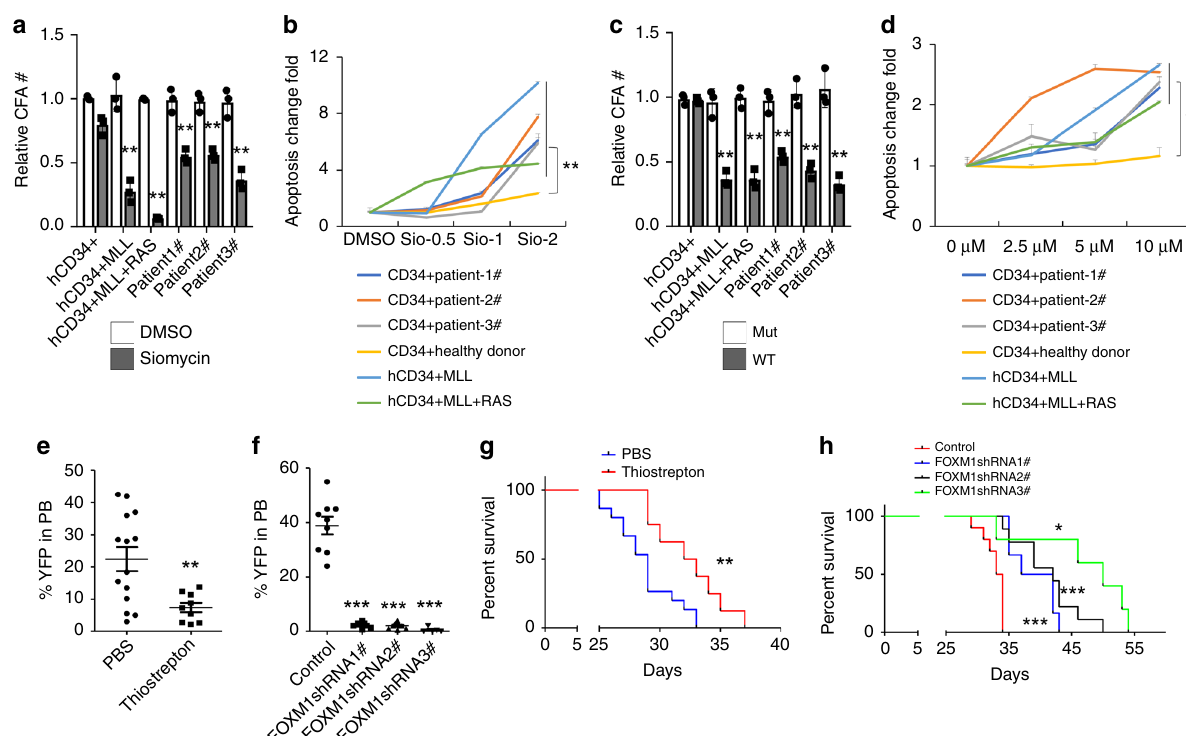
Fig. 8 Inhibition of FOXM1 suppressed MA9-transformed CD34 + cells. a, c Colony-forming assay for hCD34 + MLL cells (human CD34 + transformed by MLL-AF9), hCD34 + MLL + RAS cells (human CD34 + transformed by MLL-AF9 and RAS), primary CD34 + cells from three patients as well as normal hCD34 + cells from healthy donor treated with DMSO or 1uM Siomycin ( a ) or with 10 μ M FOXM1 Mut or WT peptide ( c ). b , d Flow cytometric analysis of apoptosis frequency of hCD34 + MLL cells, hCD34 + MLL + RAS cells, primary CD34 + cells from three patients as well as normal hCD34 + cells from healthy donor treated with DMSO or different concentration of Siomycin A( b ) or with different concentration of FOXM1 WT and Mut peptide ( d ). Apoptosis fold change was determined by comparison of Siomycin with DMSO treatment ( b ) or by comparison of FOXM1 WT peptide with Mut peptide ( d ). e Flow cytometric analysis of YFP percentage in PB cells collected from xenografted mice reconstituted with MA9.3 cells (human CD34 + transformed by MLL-AF9-YFP). The mice were treated with 50 mg/kg thiostrepton or vehicle PBS for 7 days. f Flow cytometric analysis of YFP percentage in PB